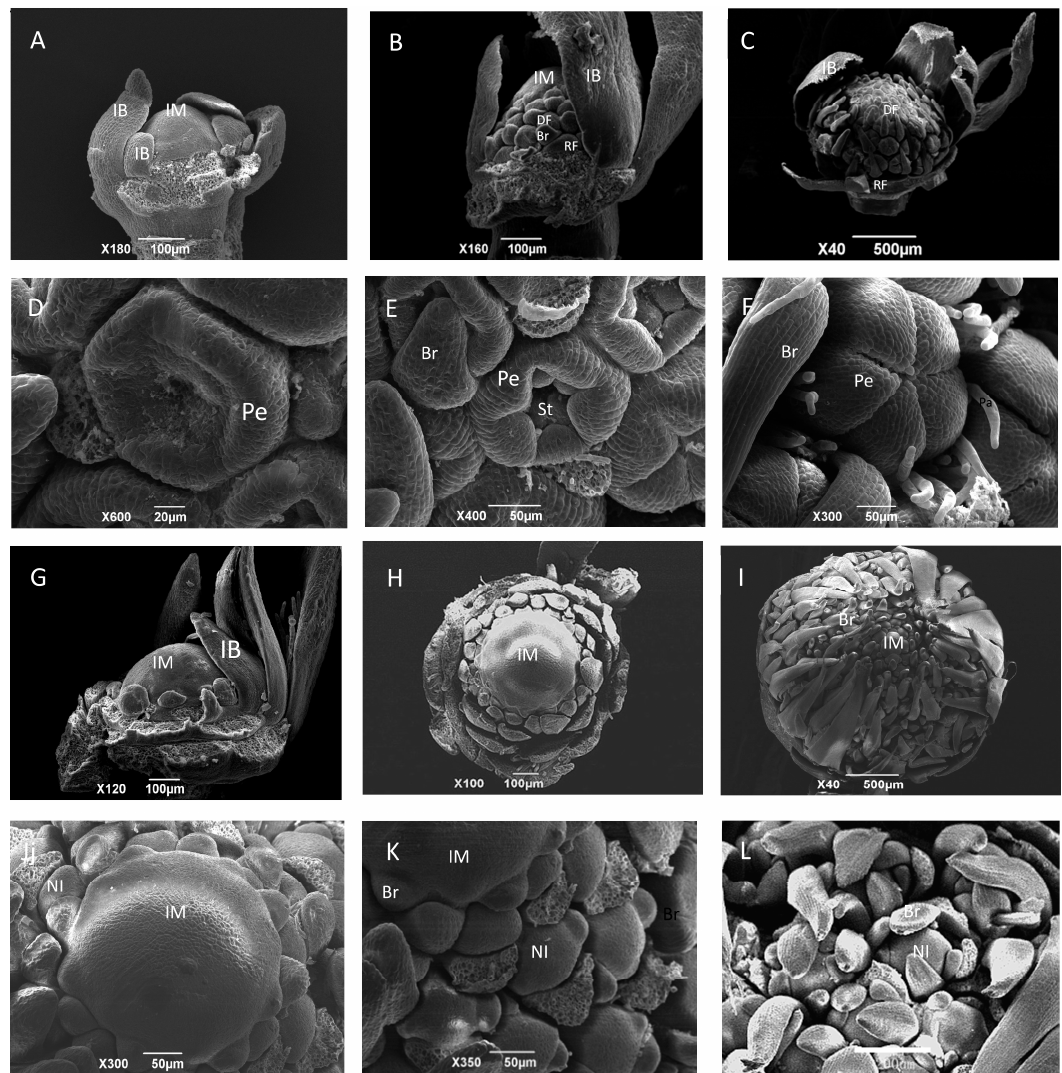
Figure 2. Anatomical observation of inflorescences in wild-type ( A – F ) and gh ( G – L ) cosmos with scanning electron microscopy (SEM). ( A ) A branch of inflorescence at the dome-shaped stage in wild-type cosmos; ( B ) the conversion of inflorescence meristems into flower meristems from bottom to apex in wild-type cosmos; ( C ) the apex of inflorescence meristem has already been converted into flower meristem in wild-type cosmos; ( D ) ring-shaped petal primordia were formed in a flower meristem of wild-type cosmos; ( E ) petal primordium was elongated and stamen primordium was formed in a flower meristem of wild-type cosmos; ( F ) the developed petals covered the stamen and carpel primordia, and the pappus bristles were formed in a flower meristem of wild-type cosmos. ( G ) A branch of inflorescence at the dome-shaped stage in gh cosmos; ( H ) the ectopic bracts emerged from the margins toward the apex in gh cosmos; ( I ) large numbers of new inflorescence meristems and ectopic bracts were formed; ( J ) the central part of the gh capitulum primordia remained undi ff erentiated; ( K ) new inflorescence meristems were formed at the base of ectopic bracts, and some ectopic bracts were removed; ( L ) the new inflorescence produced bracts at the periphery. IM, inflorescence meristem; IB, involucral bract; DF, disc flower meristem; RF, ray flower meristem; Br, bract; Pe, petal; St: stamen; Pa, pappus; NI, new inflorescence meristem. Scale bars = 20 µ m in D ; Scale bars = 50 µ m in E , F , J , K ; Scale bars = 100 µ m in A , B , H , G ; Scale bars = 200 µ m in L ; Scale bars = 500 µ m in C and I .